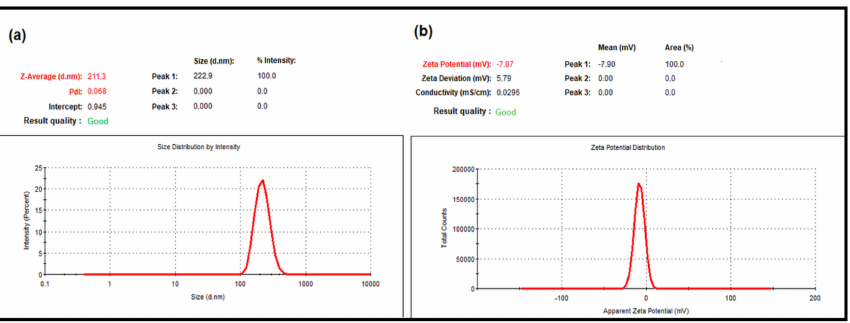
Figure 2. The photoexcited charge flow path in ( a ) type-II and ( b ) type-II band alignment of the MoTe 2 /PtS 2 vdWH. Figure 2. DLS analysis of the LNEO-NPs: ( a ) average particle size, and ( b ) zeta potential graphs.